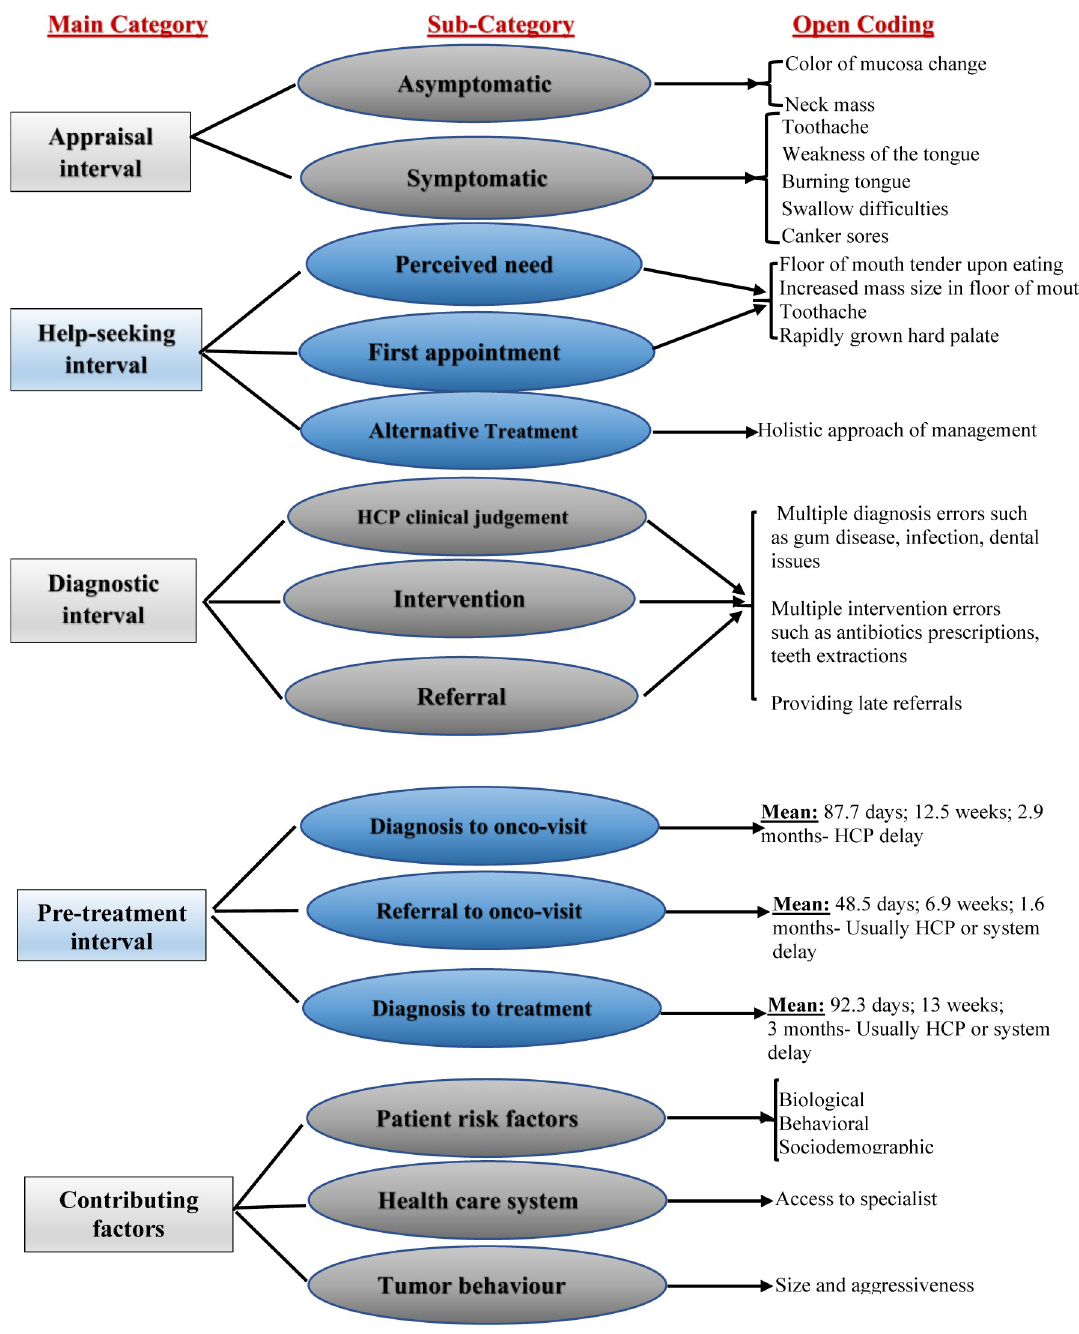
Fig 3. Deductive coding the data to the categorization